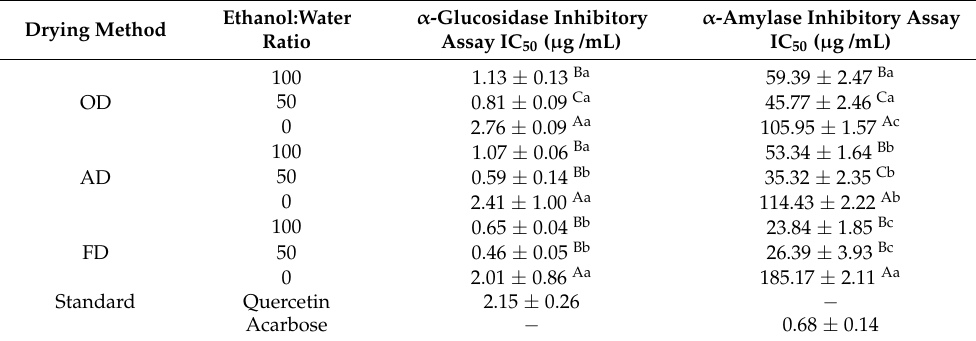
Table 1. α -Glucosidase and α -amylase inhibitory activity of M. calabura leaves dried with oven-drying (OD), air-drying (AD), and freeze-drying (FD) and extracted with 0, 50, and 100% ethanol. α -Glucosidase Inhibitory α -Amylase Inhibitory Assay Ethanol:Water Drying Method Ratio Assay IC 50 ( µ g /mL) IC 50 ( µ g /mL) OD